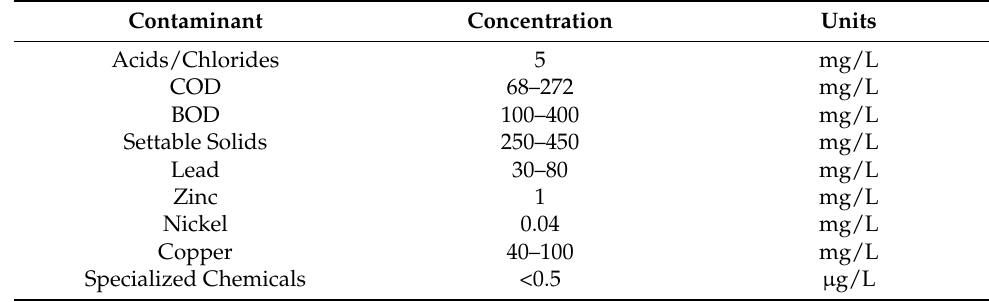
Table 1. Types of contaminants found in municipal WW (References: [8,17–19,62,84]).